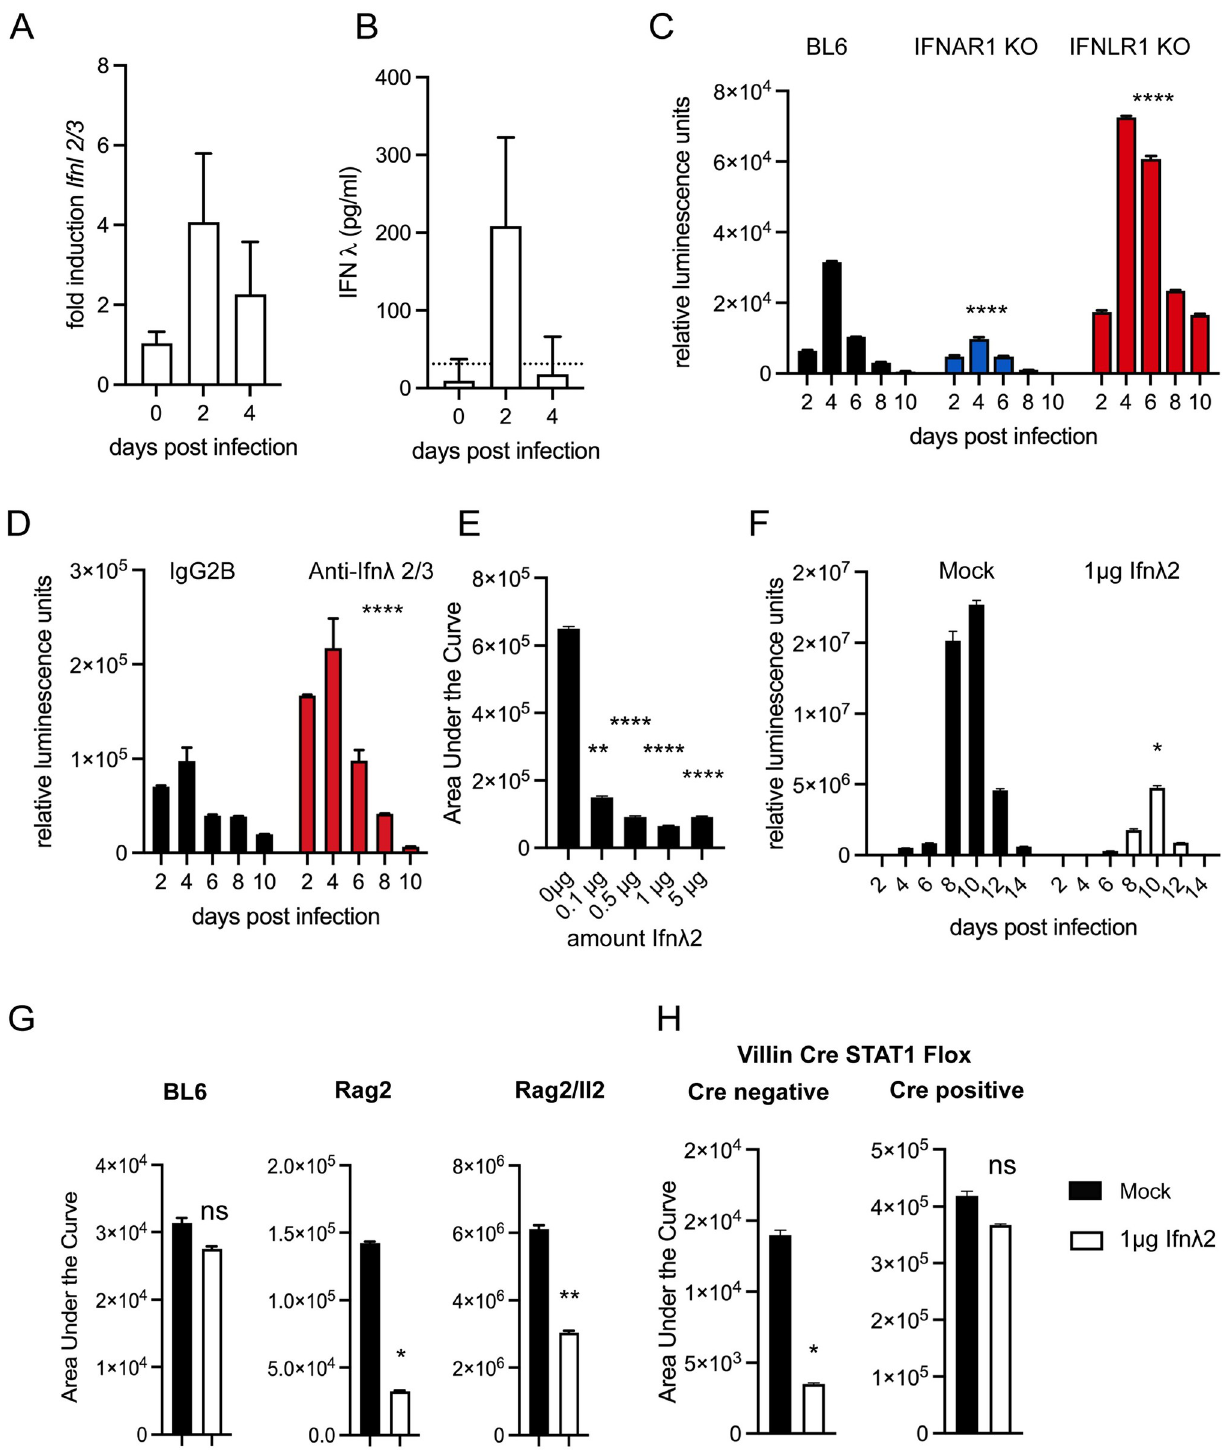
Fig 4. The type III Interferon response is host protective and epithelial cell intrinsic. We used a mouse model of infection to examine the role of type III interferon in Cryptosporidium infection in vivo . All mice were infected with mouse adapted C . parvum . (A) C57/BL6 (BL6) mice were infected with 50,000 C . parvum oocysts and relative abundance of IFN λ transcript is shown for ileal biopsies of infected mice, 8–10 mice per day, n = 3 independent biological replicates. (B) BL6 mice were infected with 50,000 C . parvum oocysts and secreted IFN λ protein from ileal biopsies was assessed by ELISA, 8–10 mice per day, n = 3 independent biological replicates. Dotted line represents the limit of detection. (C) Fecal luminescence measured every two